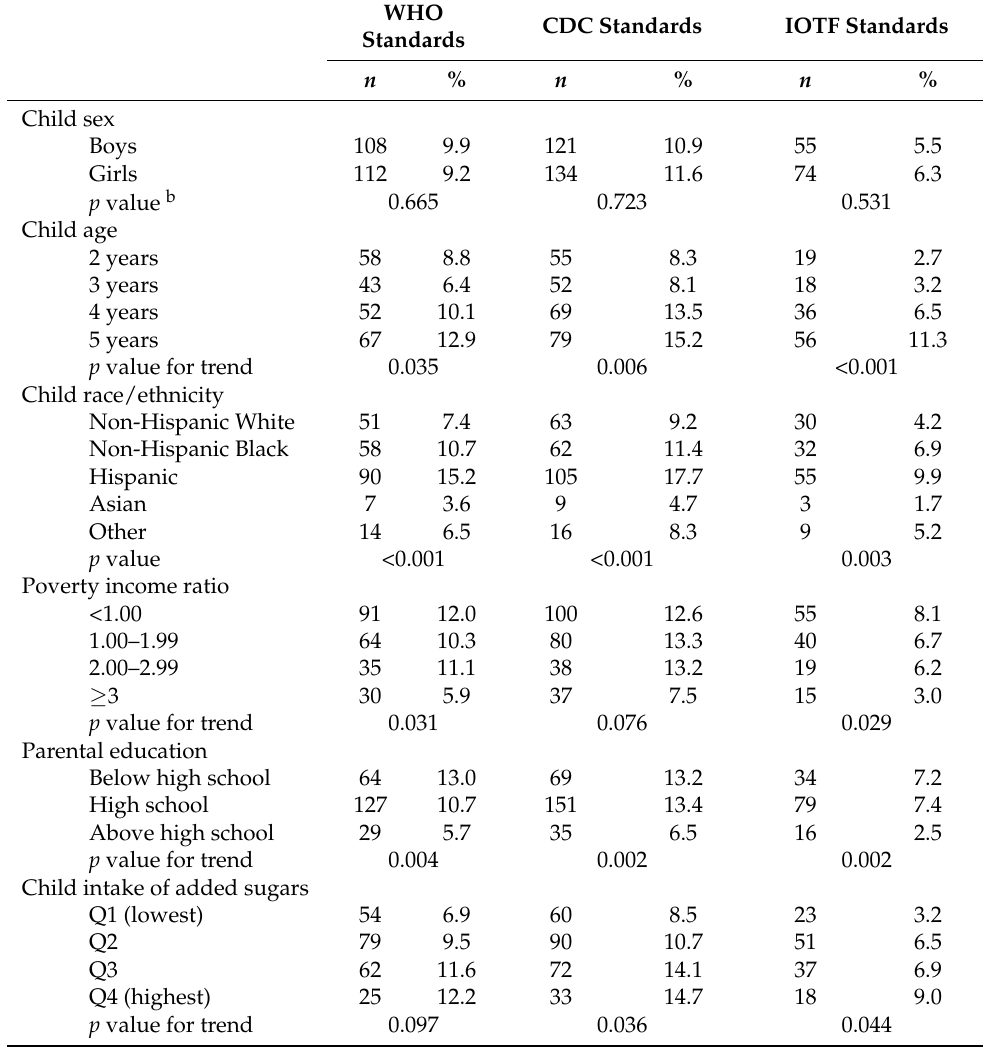
Table 2. Prevalence of obesity (as defined by three international standards a ) by sociodemographic and behavioural factors ( n =